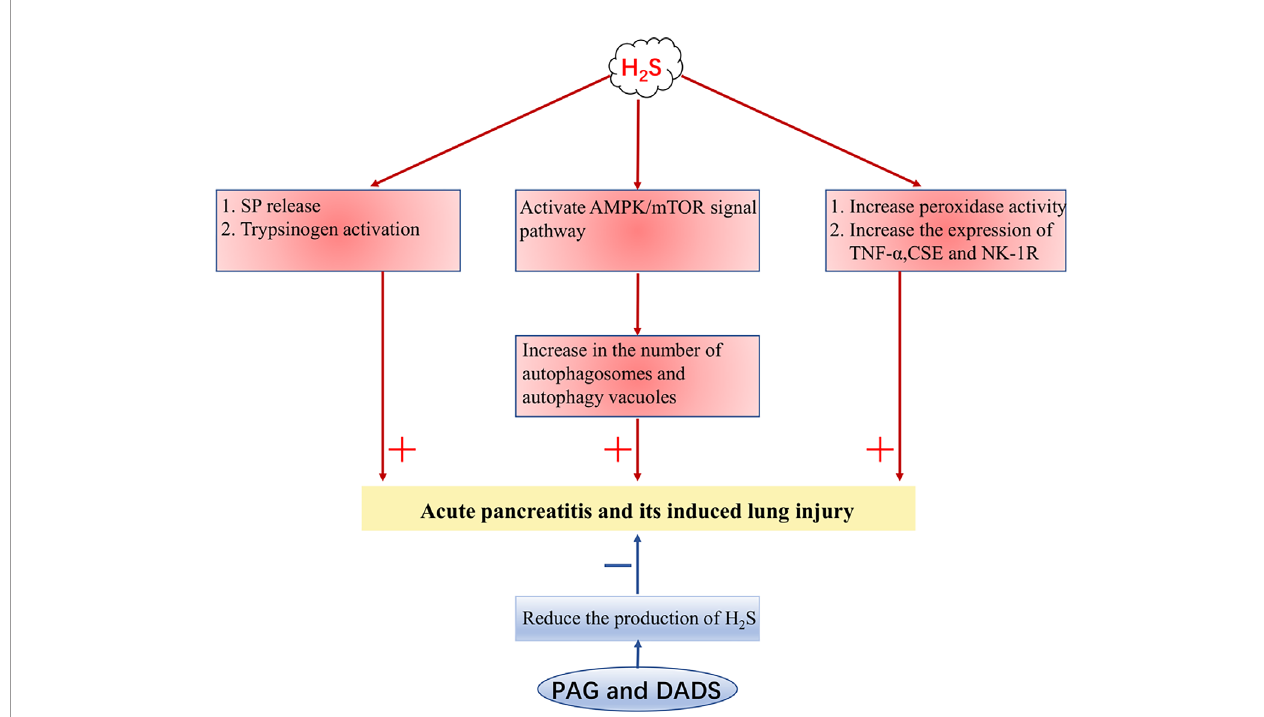
FIGURE 2 | H 2 S aggravates acute pancreatitis. H 2 S, hydrogen sul fi de; SP, substance P; TNF- a , tumor necrosis factor- a ; NK-1R, neurokinin-1 receptor; CSE, cystathionine g -lyase; PAG, DL-Propargylglycine; DADS, diallyl disul fi de. + indicates aggravate, - indicates